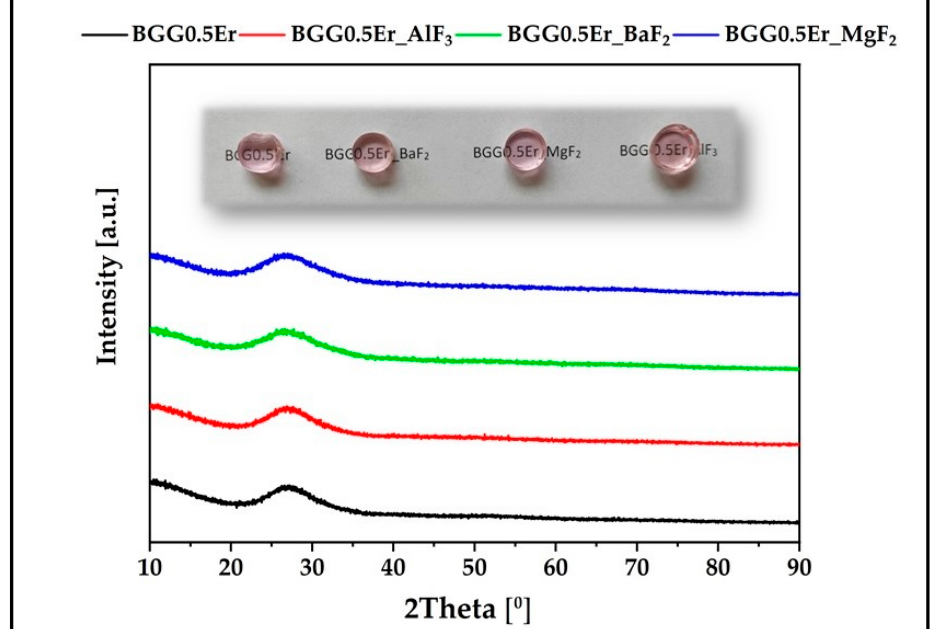
Figure 1. X-ray diffraction patterns of glasses. Pictures of the fabricated glasses